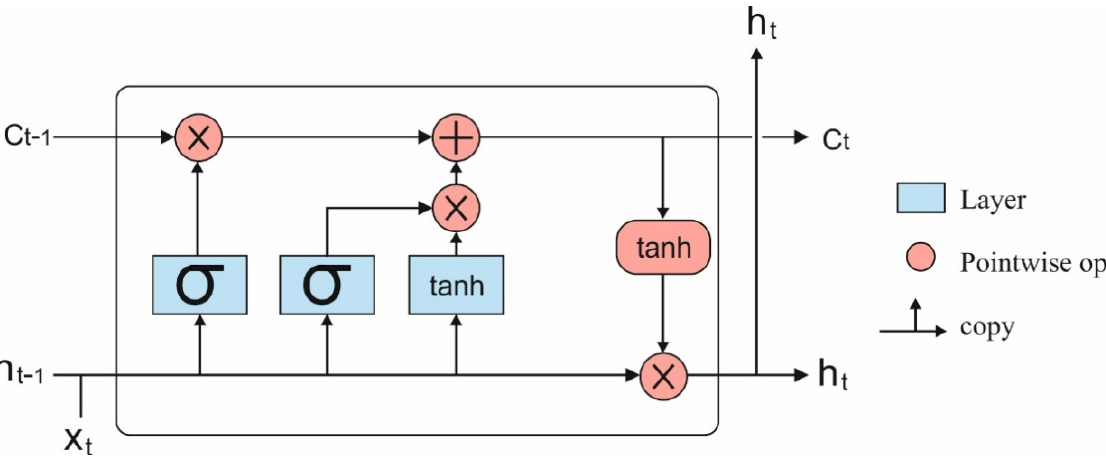
Figure 4. The Structure of LSTM.